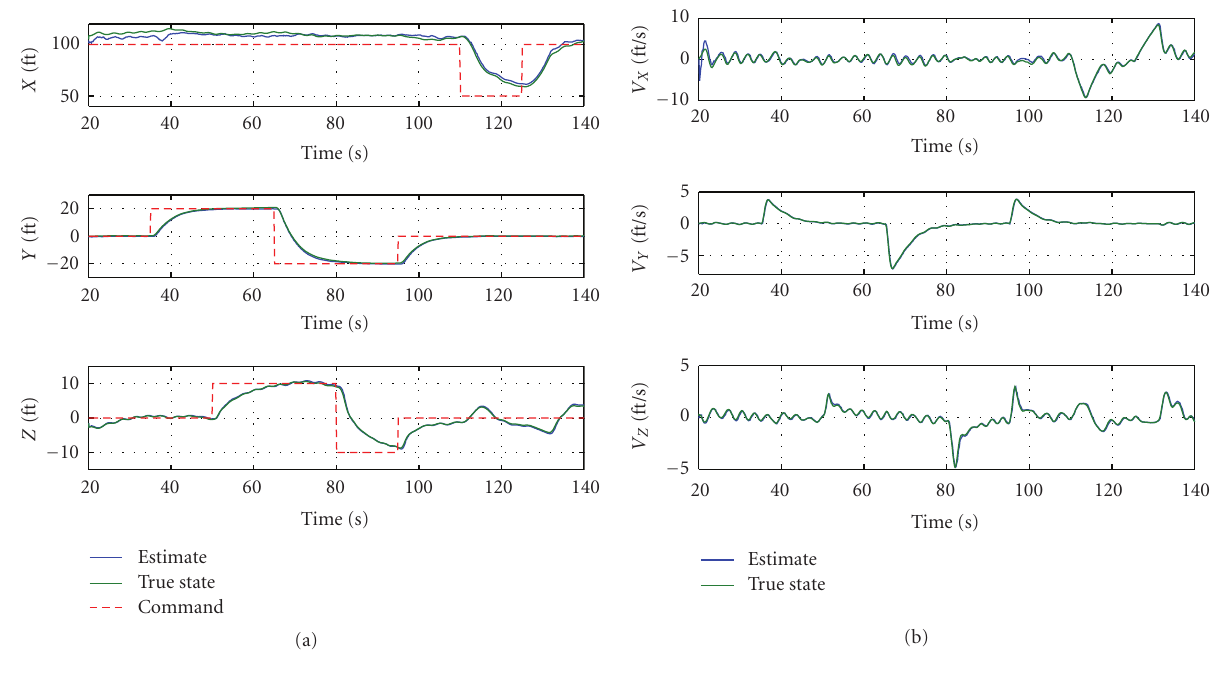
Figure 4: Estimated versus true relative position and